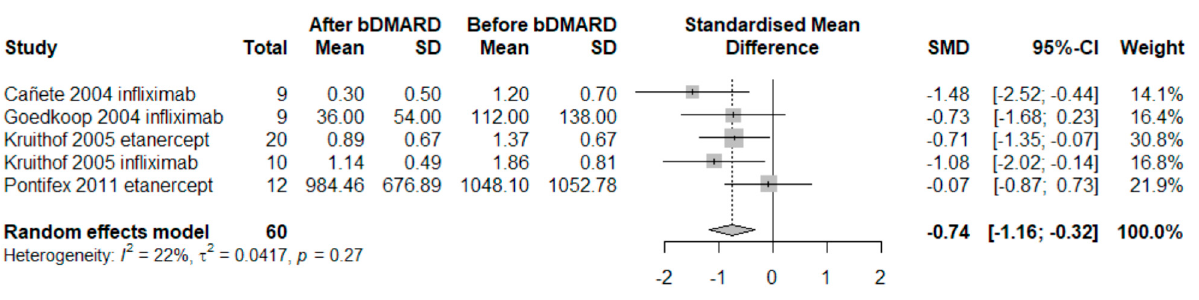
Figure 3. Forest plot of standardized mean difference (SMD) of CD68+ macrophages in sublining synovial tissue of PsA patients treated with bDMARDs (TNFis). Negative effect means reduction in CD68+ macrophage level. Abbreviations: bDMARD: biological disease-modifying anti-rheumatic drug, SD: standard deviation, SMD: standardized mean difference; 95% CI: 95% confidence